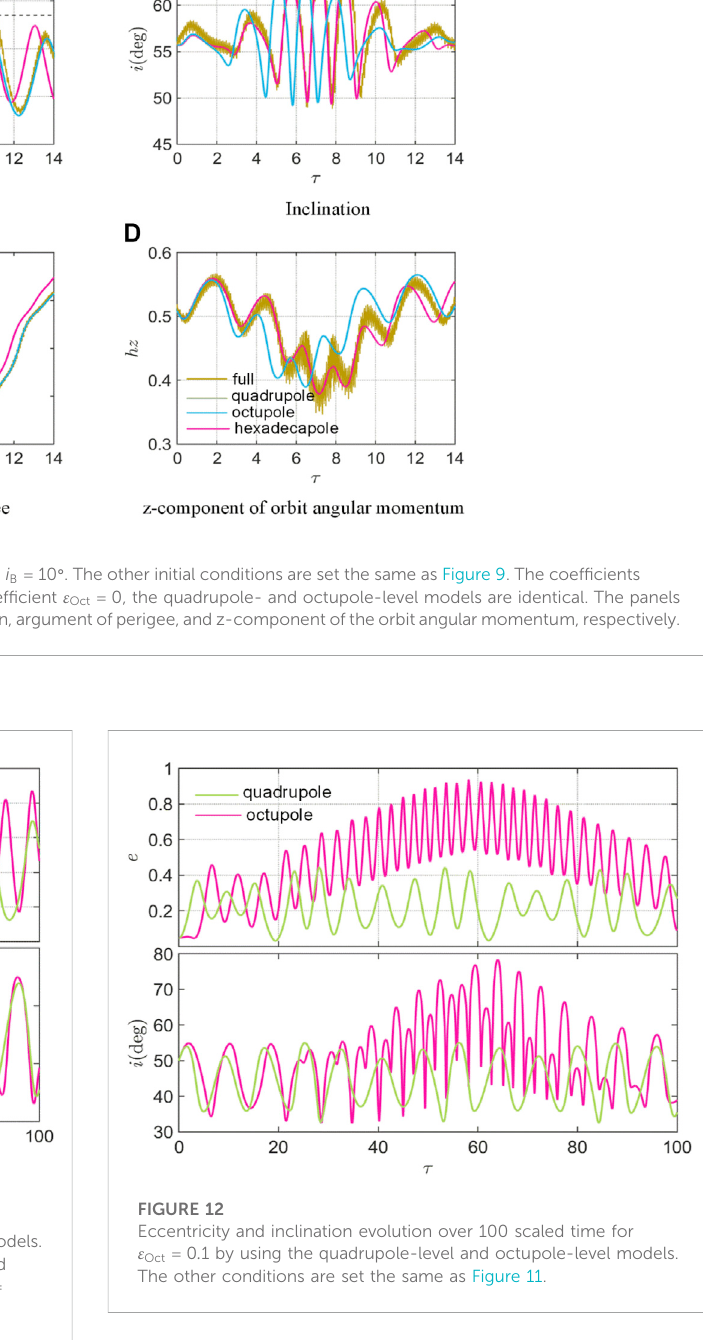
ε (cid:2) 0 . 1, and i Oct